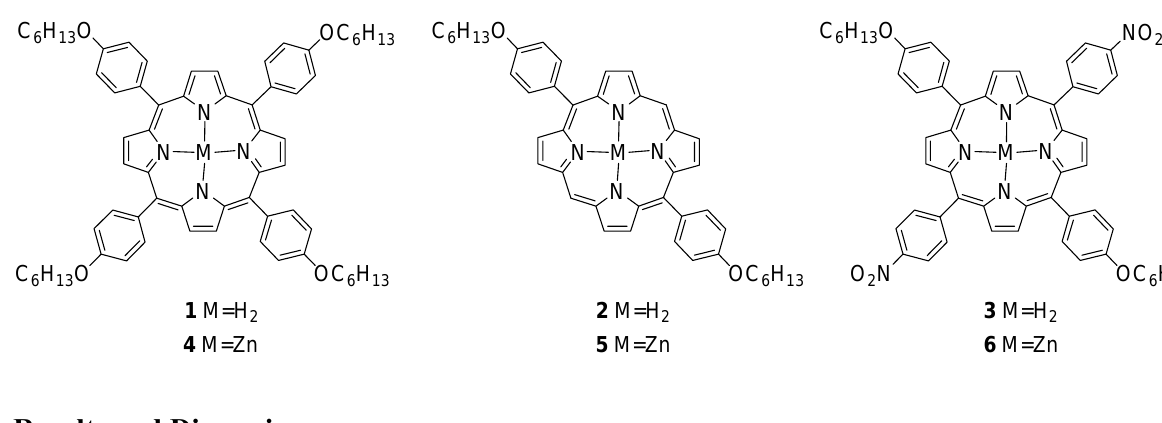
Figure 1. Molecular structures of the di- and tetra-phenyl